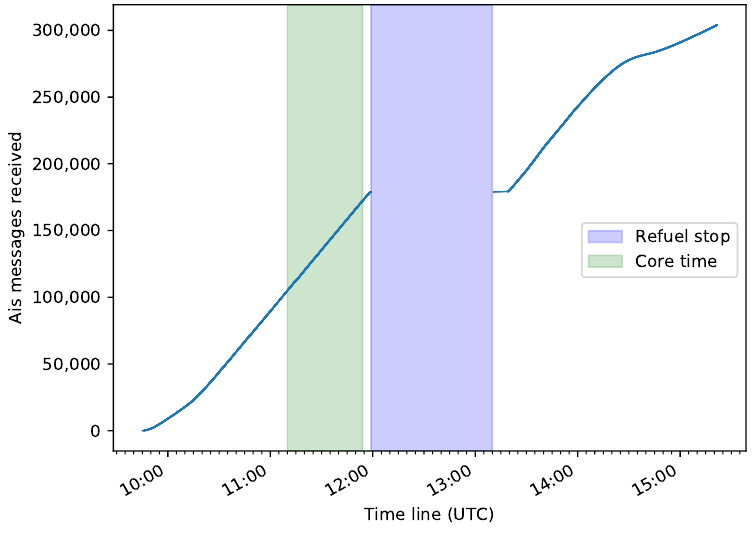
Figure 9. Aggregation of received AIS messages during the operating